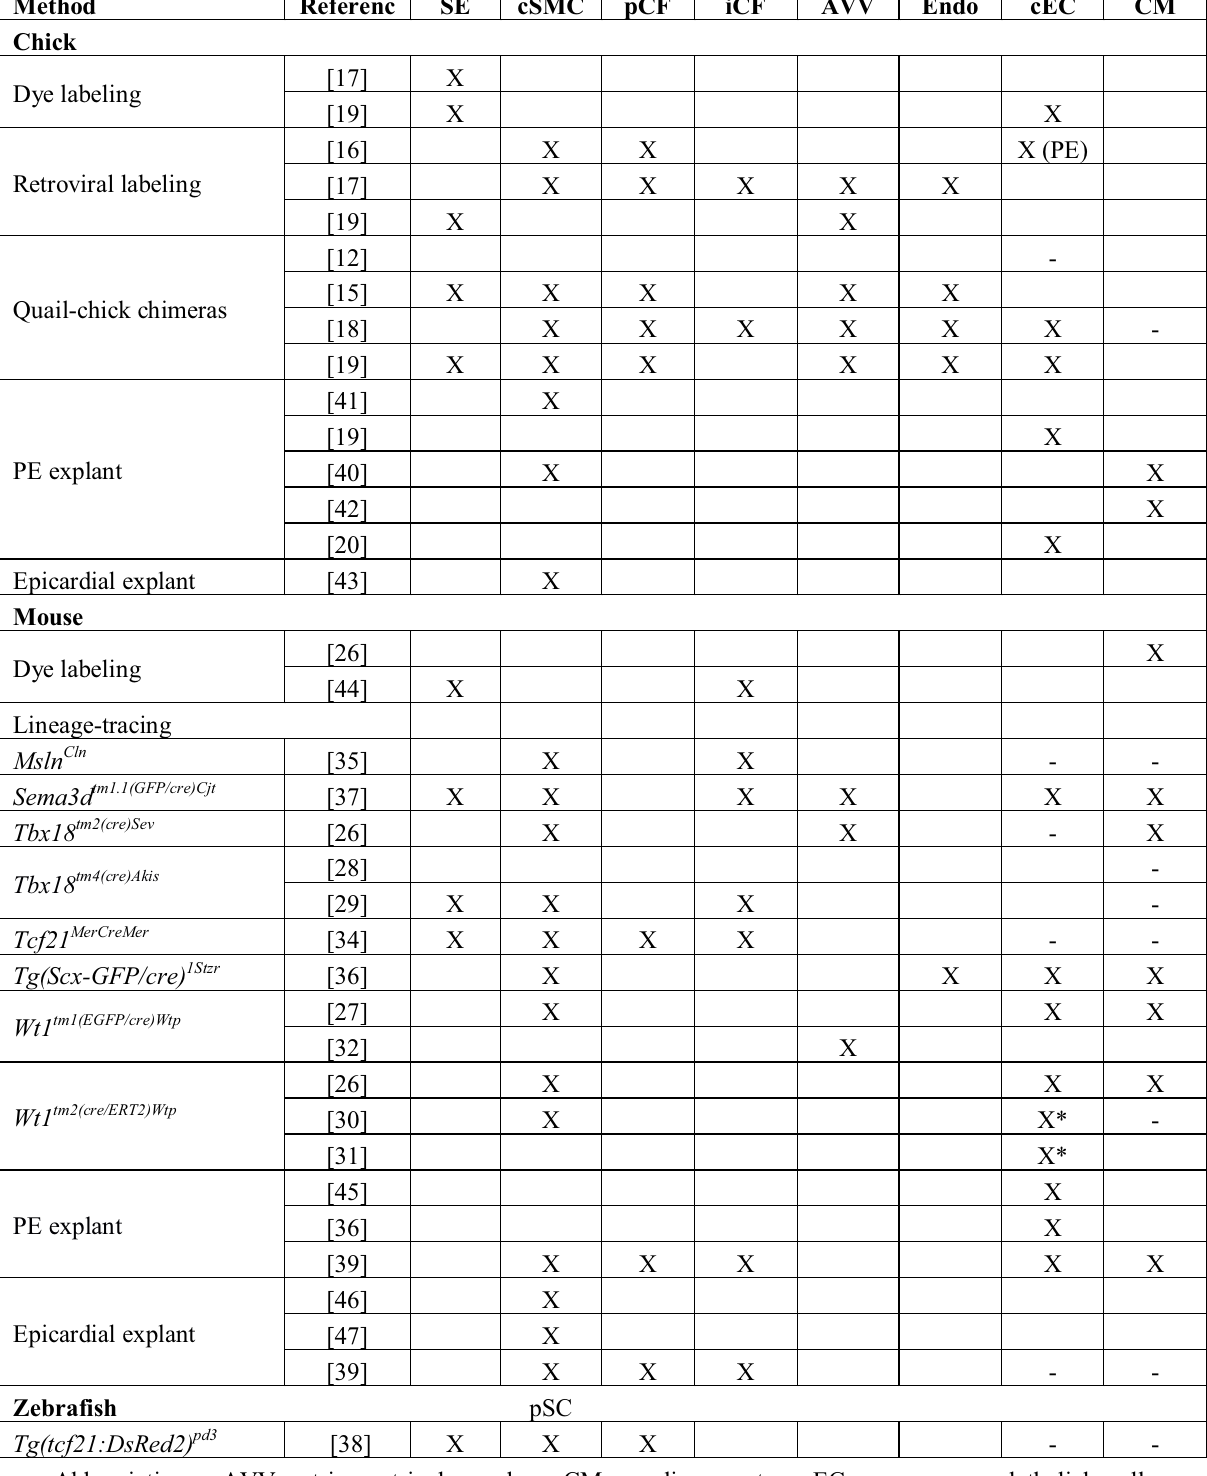
Table 1. Fate of (pro-)epicardial cells in chick, mouse and zebrafish embryos. Method Chick Dye